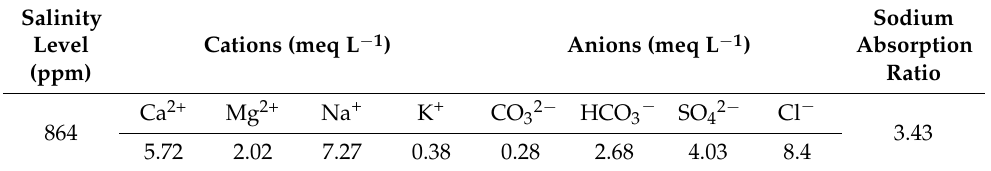
Table 1. The chemical composition and properties of the irrigation